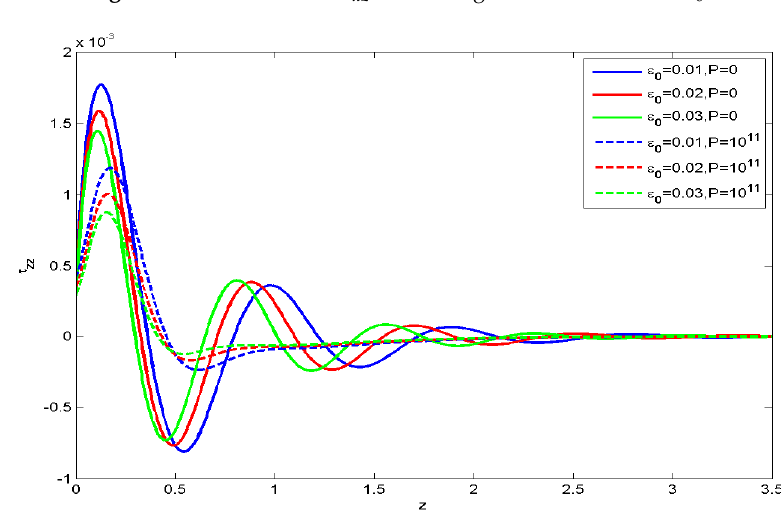
Figure 15. Maxwell stress τ zz concerning z with electric field ε 0 .